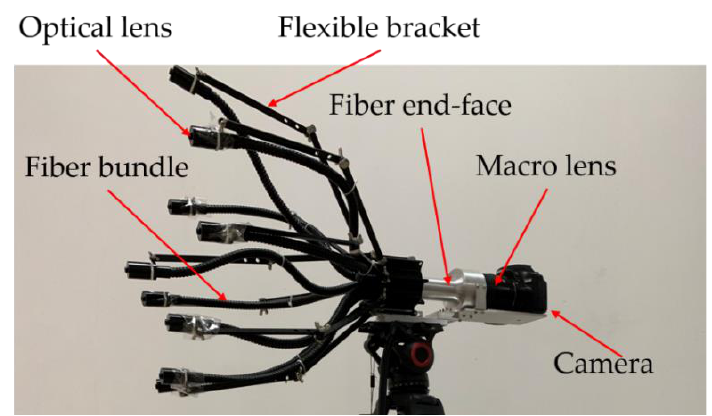
Figure 1. Structure of compound-eye system.